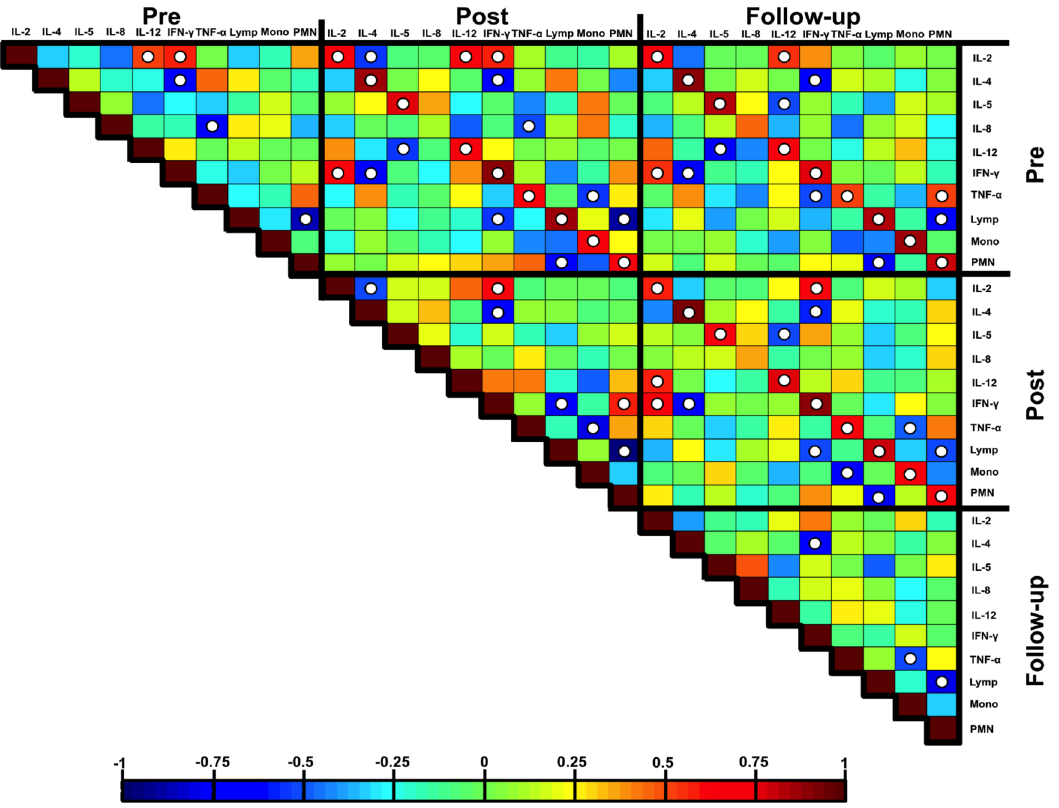
Fig 6. Spearman correlations for pre, post and 22-hour post DE+O 3 co-exposure responses.A white dot in a cell indicates a statistically significant (p < 0.05) positive or negative correlation. Lymph = lymphocytes, Mono = monocytes, PMN = polymorphonuclear neutrophil.